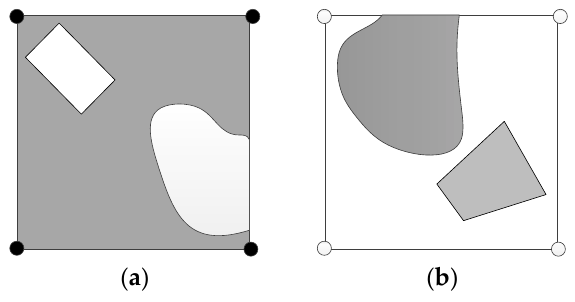
Figure 15. Exceptions for grid subdivision. ( a ) holes; ( b ) islands.